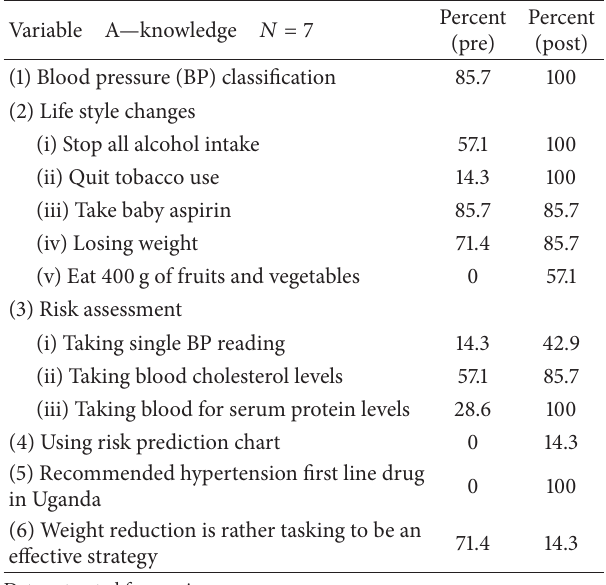
Table 1: Demographic characteristics.